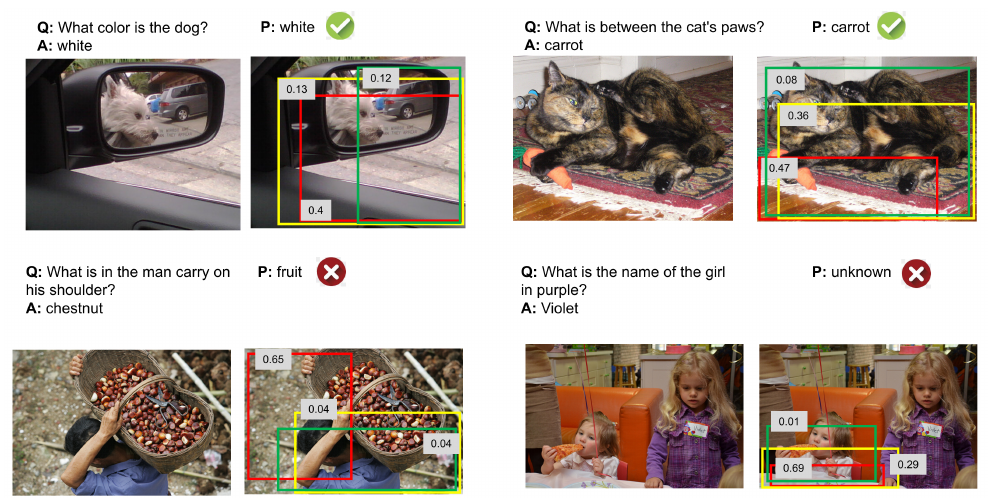
Figure 10. The qualitative evaluation and typical examples of the images region attentions of our model. The top row examples are the correct predictions, while the bottom row shows two incorrect predictions. For each example, we select the top 3 largest image region weight for visualization, mark the corresponding regions with boxes, and the numbers on the boxes represent the corresponding weights of the image